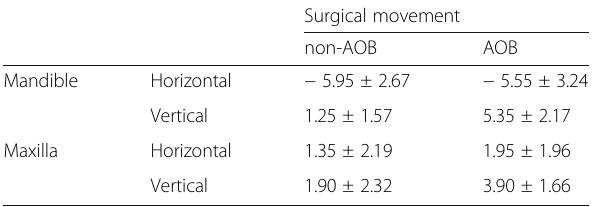
Table 1 Surgical movements following two jaw surgery for mandibular setback movement Surgical